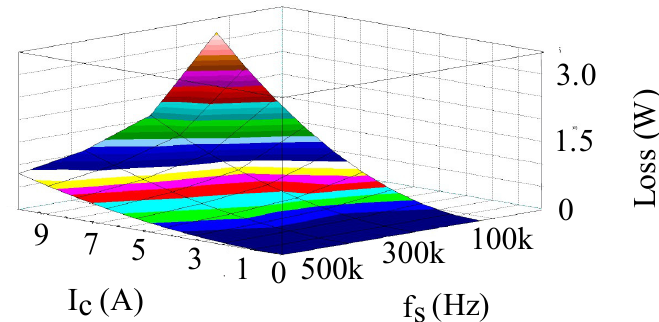
Figure 15. Behavior of losses in a capacitor as function of the RMS current and operation fre- quency.